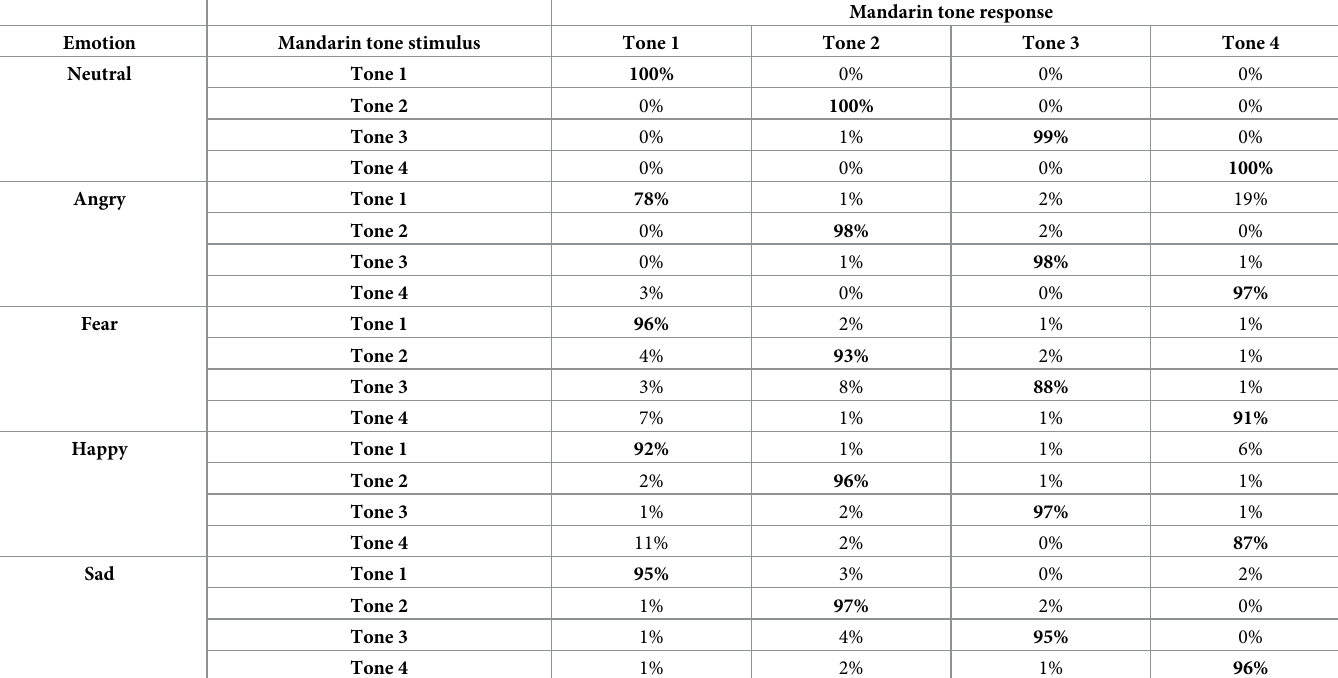
Table 5. Confusion matrices of Mandarin tone identification responses for syllables presented in context across emotions.